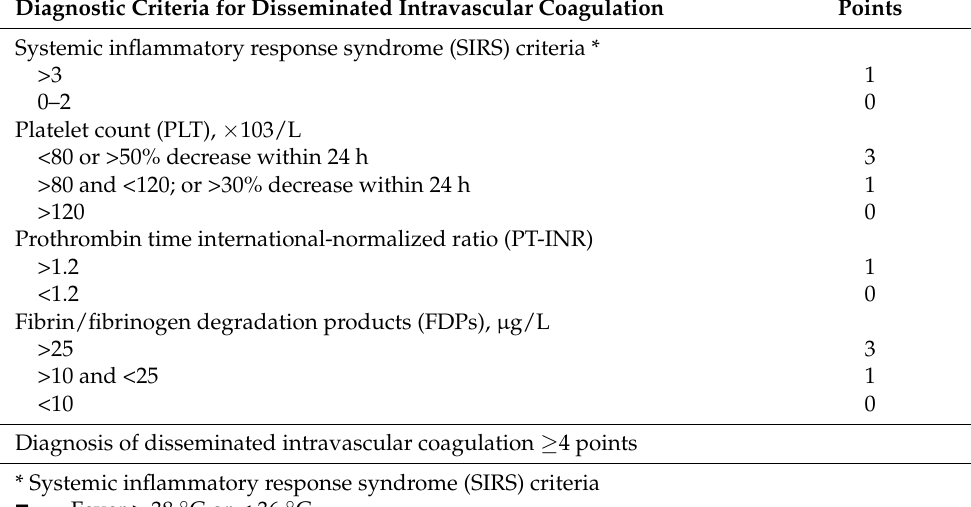
Table 1. Diagnostic criteria for disseminated intravascular coagulation as defined by the Japanese Association for Acute